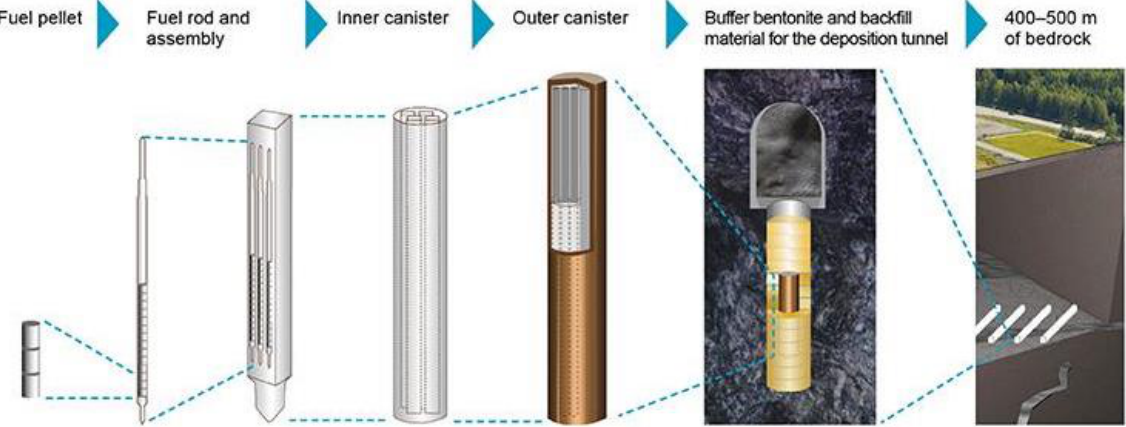
Figure 1. Schematic illustration of management and direct disposal of spent nuclear fuel according to the KBS-3 method (Copyright: Posiva Oy).